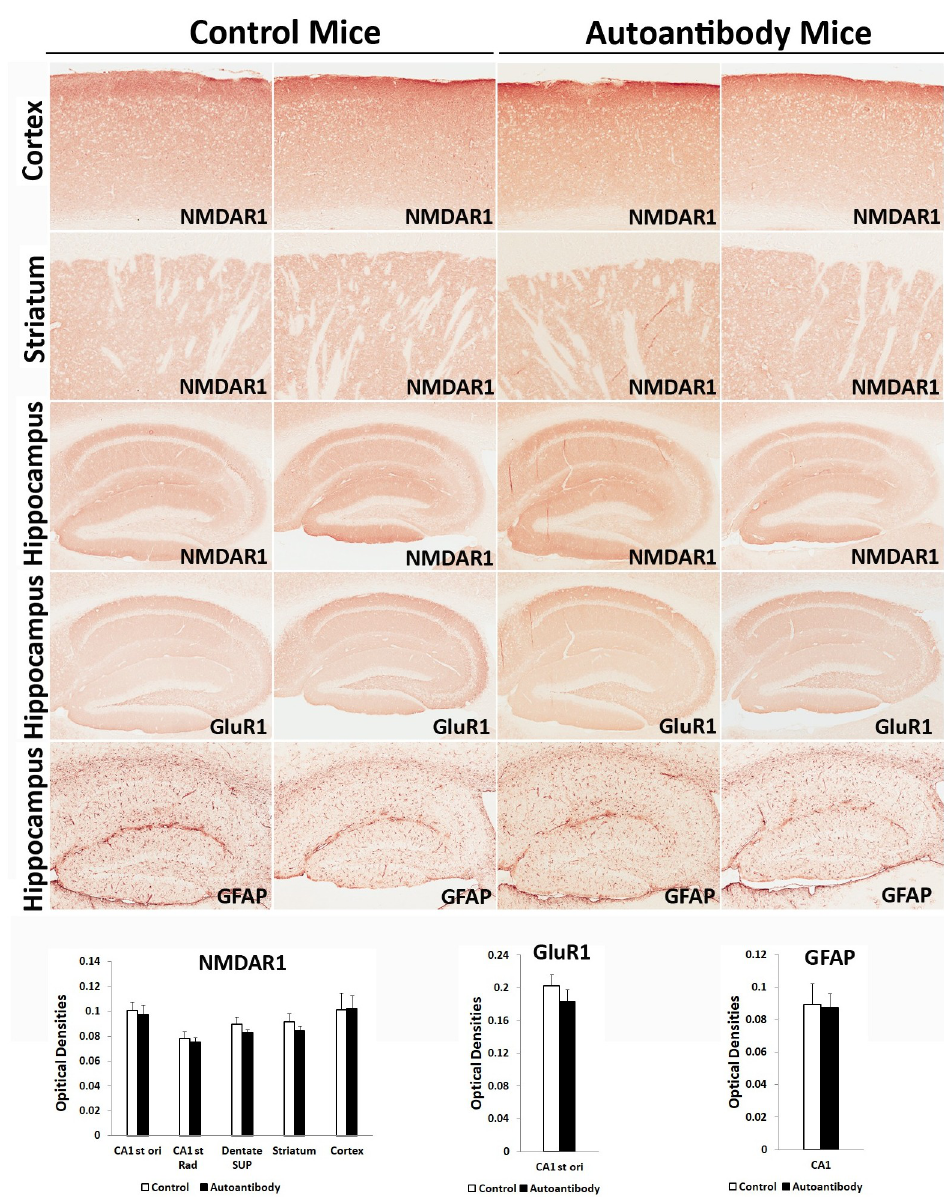
Fig 11. Lack of significant differences of NMDAR1, GluR1, and GFAP in the brains of mice chronically carrying the anti-NMDAR1 autoantibodies. 5 pairs of mice with or without the anti-NMDAR1 autoantibodies were sacrificed to examine expression of NMDAR1, GluR1, and GFAP in hippocampus, cortex, and striatum. Representative staining of two mice from each group are shown. Image J was used to quantify the optical densities of the staining at different brain regions. There are no significant differences in expression of NMDAR1, GluR1, and GFAP between the control mice and the mice carrying the anti-NMDAR1 autoantibodies. Data were presented as